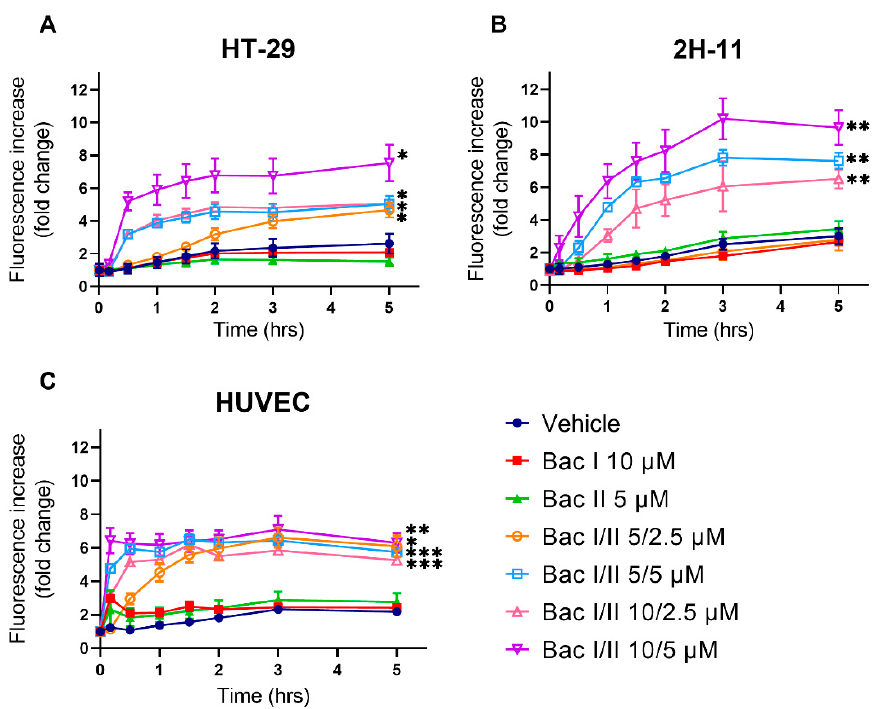
Figure 6. Bac I and II combined induced an increase in cytosolic Ca 2+ in HT-29, 2H-11 and HUVEC. HT-29 ( A ), 2H-11 ( B ) and HUVEC ( C ) were treated with bac I and II, either alone or in combination, and cytosolic Ca 2+ was monitored over 5 h by a Fluo-8 assay. Data represent the mean fractional increase in fluorescence with respect to time 0 of triplicates. Error bars represent the SD. Significant difference as compared with the vehicle after 5-h of treatment is indicated by asterisks * p < 0.05; ** p < 0.01; *** p < 0.001).